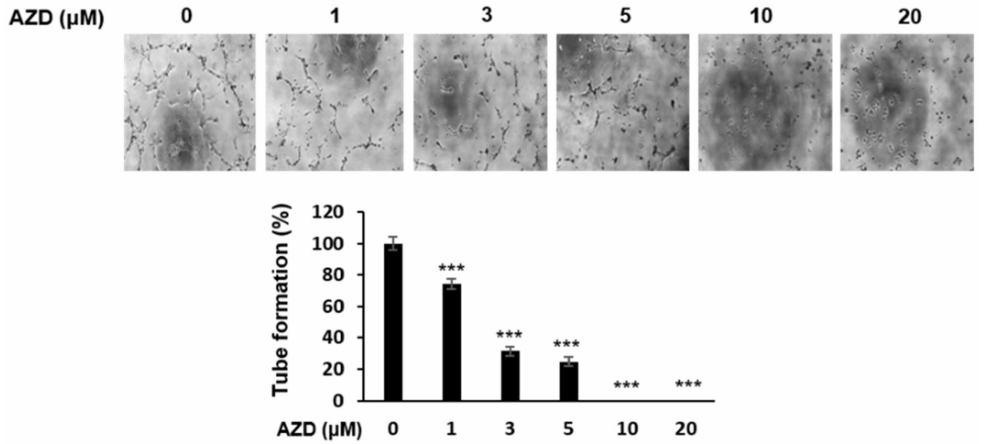
Figure 6. AZD4547 inhibits angiogenesis. Human umbilical endothelial cells were plated into Matrigel-covered wells and treated with AZD4547 for 2 h, followed by serum treatment, to stimulate tube formation. Upper panel, representative images of tube formation. Lower panel, quantification of tube formation. AZD, AZD4547. *** p <